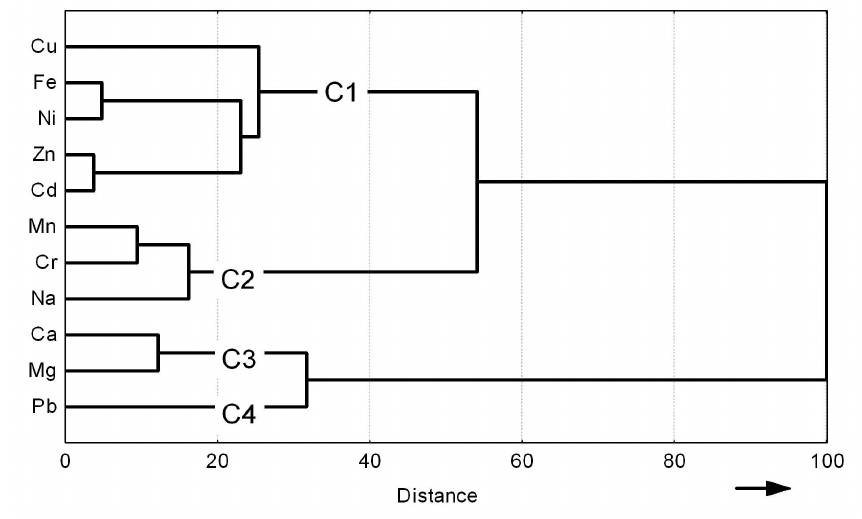
Fig. 4 Hierarchical dendrogram for classification of the chemical